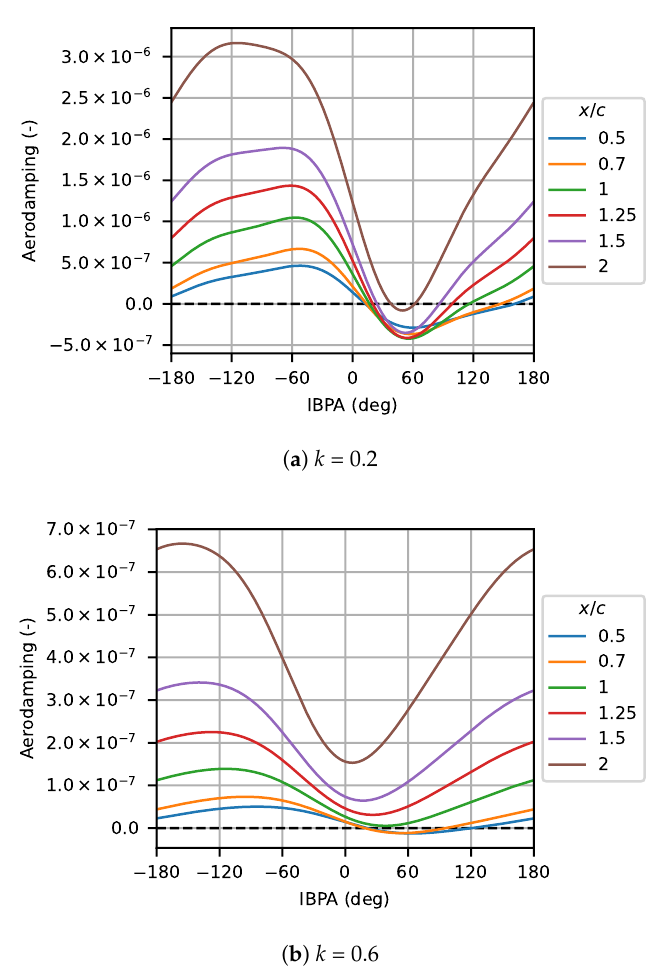
Figure 13. Aerodamping as a function of the inter-blade phase